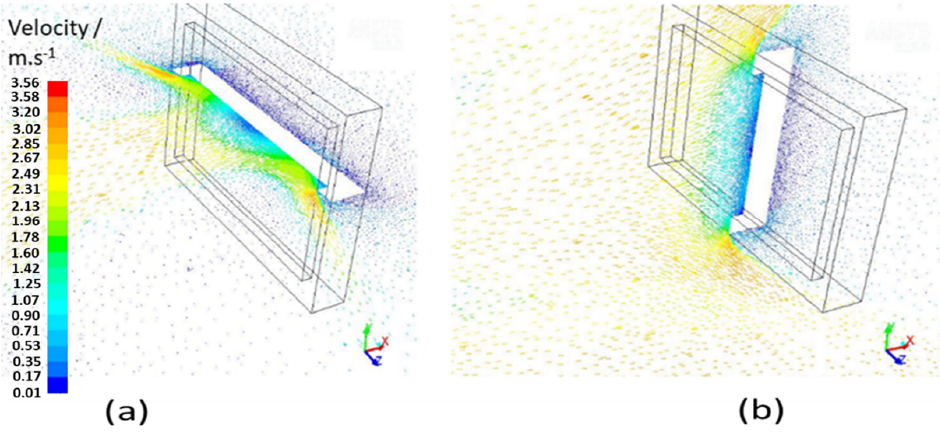
Figure 8. Velocity vectors at the receiver surface from two different cross − sectional views. ( a ) Latitu- dinal view ( b ) Longitudinal view.